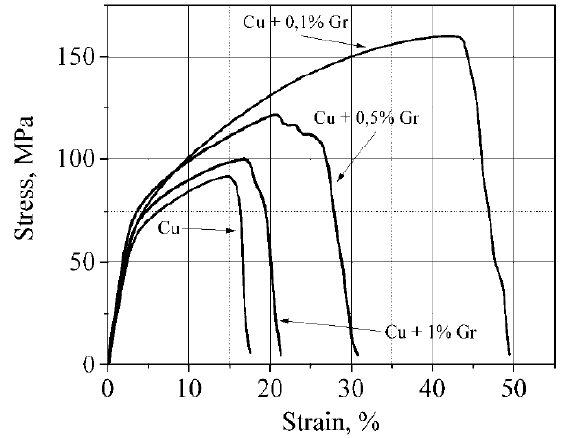
Fig. 7. Stress-strain diagrams obtained for Speci- mens